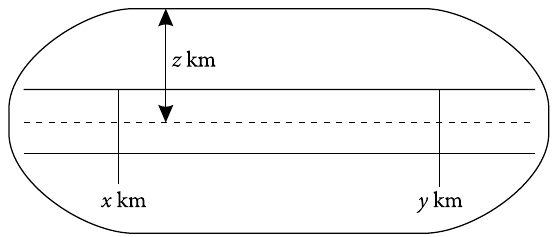
Fig. 2. Road section area where population is counted